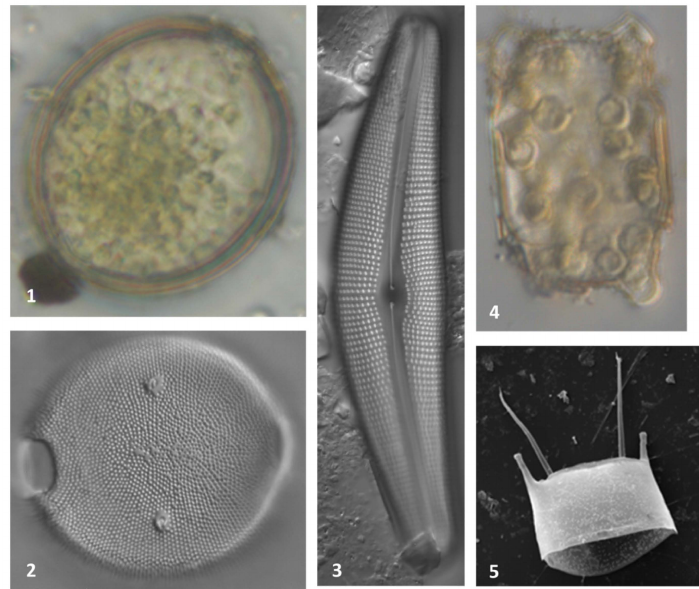
Figure 3. Diatom taxa corresponding to 95% or greater similarities based on molecular identification: ( 1 , 2 ) Pleurosira laevis ; ( 3 ) Cymbella aspera ; ( 4 ) Odontella (Biddulphia) sp. live; ( 5 ) Odontella (Biddulphia) sp. girdle band; ( 1 – 4 ) light microscope images; ( 1 , 4 ), live images; and ( 5 ) SEM image. Scale bar 10 µ